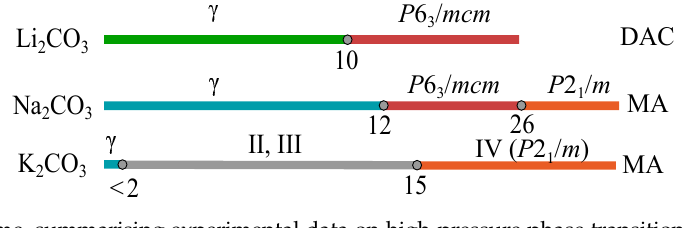
setting; Figure S4: Diffraction patterns in DAC-SSTRC (a), DAC-APS (b), and multianvil (c) settings at 2.3–3.6 GPa. Grey bands are shown for the convenience of visual comparison; Figure S5: Diffraction patterns of K 2 CO 3 -IV recorded in DAC-APS (a) and multianvil (b) settings; Figure S6: Phonon dispersion curves of Na 2 CO 3 phases, Pmmn at 0 GPa (a), γ at 12 GPa (b), and P 6 3 / mcm at 24 GPa (c) and P 2 1 / m at 36 GPa (d); Figure S7: Phonon dispersion curves of K 2 CO 3 phases, β at 0 GPa (a), γ at 1 GPa (b), P 2 1 / m at 36 GPa (c) and C 2/ c at 60 GPa (d); Figure S8: Na-O polyhedrons in P 6 3 / mcm (a) and P 2 1 / m (b) crystal structures of Na 2 CO 3 . Table S1: Unit cell parameters of γ -Na 2 CO 3 from DAC-APS experiments; Table S2: Structural data of K 2 CO 3 - C 2/ m used for indexing of experimental diffraction pattern (according to DFT calculations, without